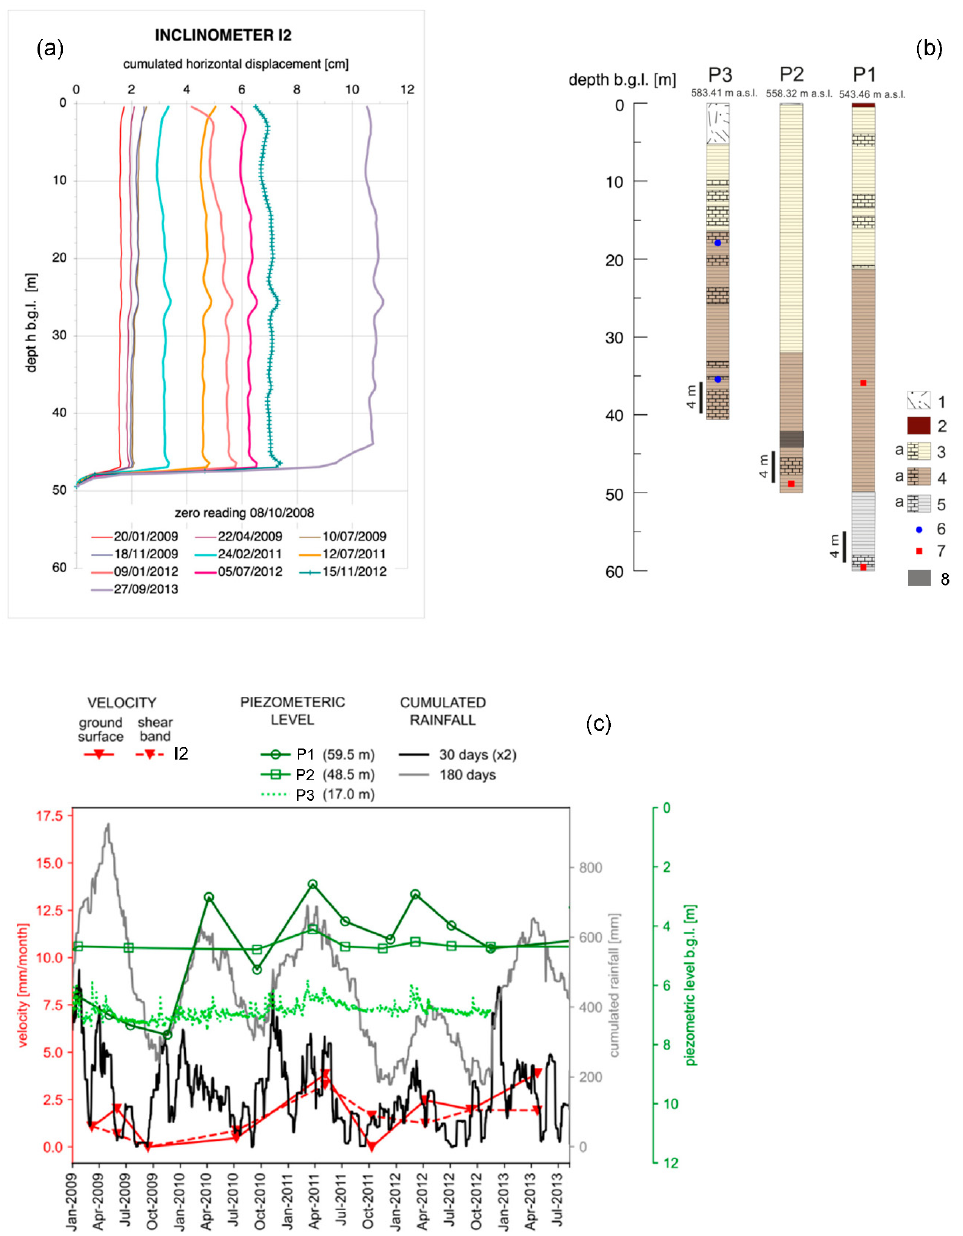
Figure 9. Bovino: landslide processes. ( a ) Inclinometer I2; ( b ) borehole logs P1, P2 and P3; ( c ) effect of cumulated rainfall on slope movements and porewater pressure. Key of ( b ): (1) made ground; (2) topsoil; (3) altered cover of clayey Faeto Flysch; (4) clayey Faeto Flysch; (5) Faeto Flysch–Red Flysch transition (symbols indicate calcarenitic levels); (6) electric piezometer; (7) Casagrande piezometer; (8) signs of remoulding. Casagrande piezometers installed in the slope measured high pressure heads down to great depth. As in other cases where the FAE is involved (e.g., Volturino, Section 3.2), the landslide exhibits seasonal accelerations related to the oscillation in the piezometric